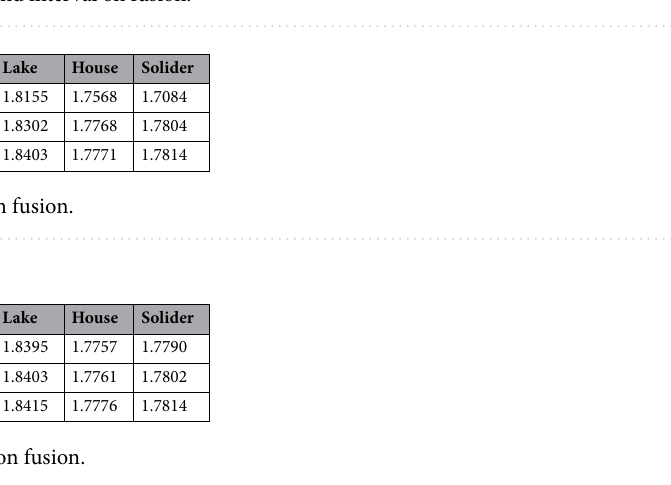
Figure 6. Influence of octave and interval on fusion.